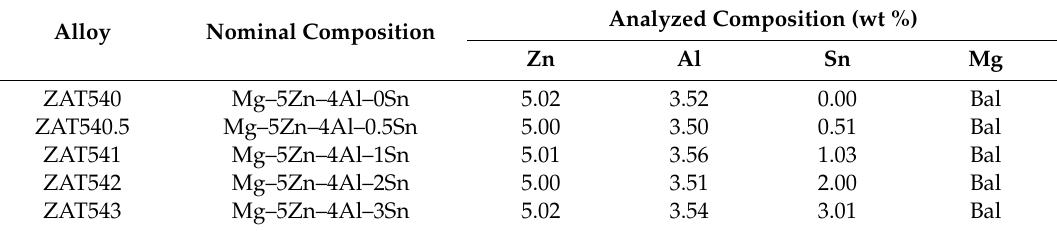
Table 1. Composition analysis of cast Mg–5Zn–4Al–xSn (ZAT54x)